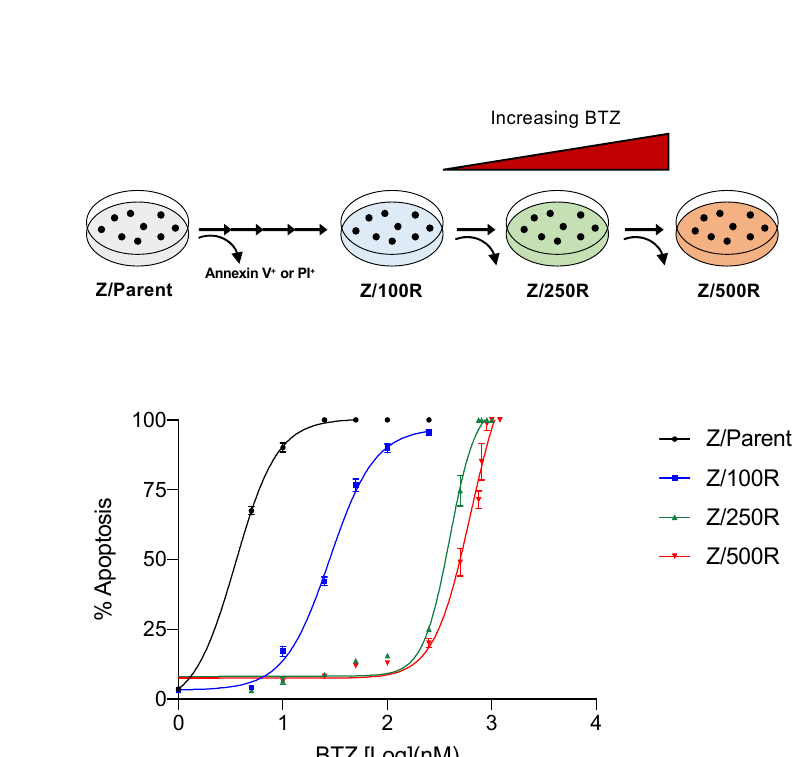
Figure 1. Generation of de novo BTZ-resistant MCL cells. ( A ) Schematic diagram for the establishment of BTZ-resistant Z-138 cells at different degrees from parental (Z/Parent) cells by stepwise selection method. ( B ) Parental Z/Parent cells and BTZ-resistant Z/100R, Z/250R, and Z/500R cells were treated with various concentrations of BTZ (0–1200 nM), and apoptosis was determined by the Hoechst 33342 assay at 24 h. Dose-response (best-fit) curves were generated on the logarithmic scale of drug concentrations as opposed to the linear scale of percentage of apoptosis. Data are mean ± SD ( n = 3).